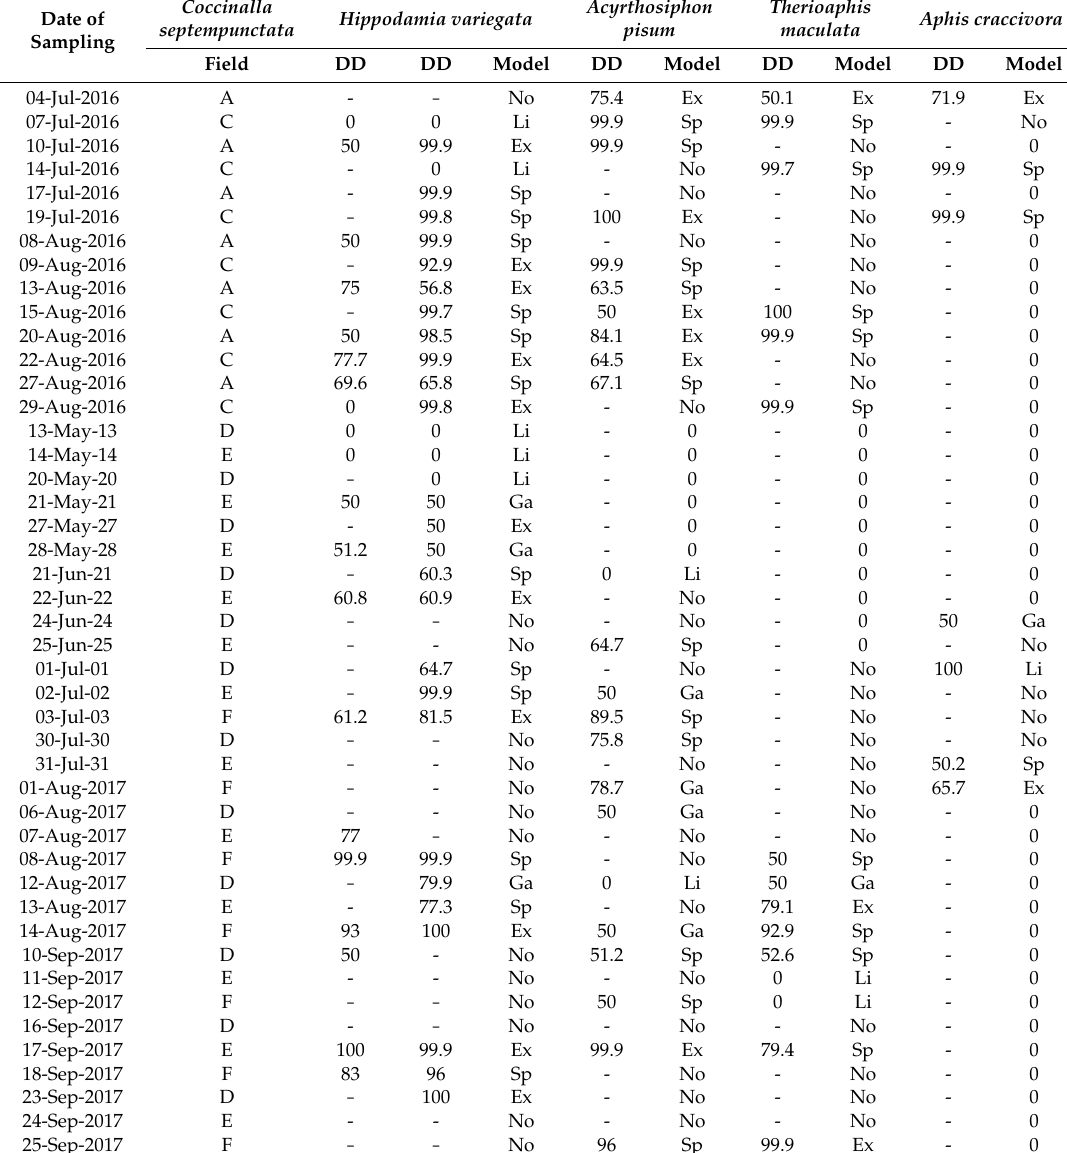
Table 2. Geostatistical degree of dependence and best -fitted variogram models for coccinellids and aphids sampling data in alfalfa